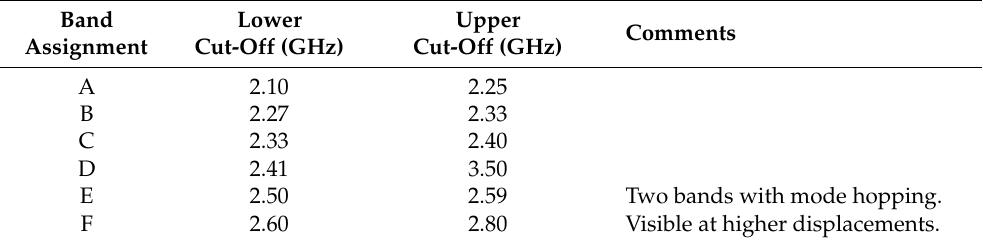
Figure 4. Variation in S 21 as filter 2 is displaced from filter 1 in the y direction. Table 1. Designation of features seen in the S 21 traces.